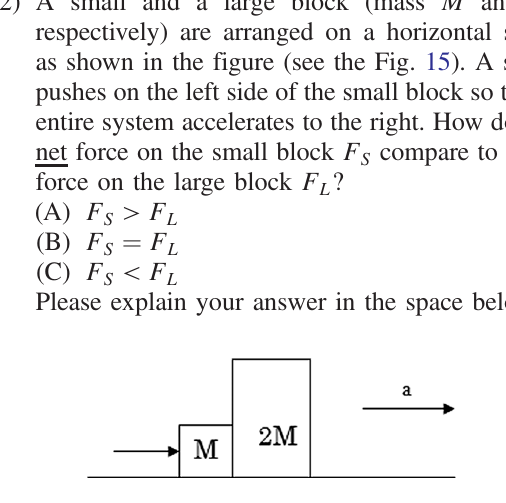
FIG. 15. Figure for Newton ’ s laws post-test problem